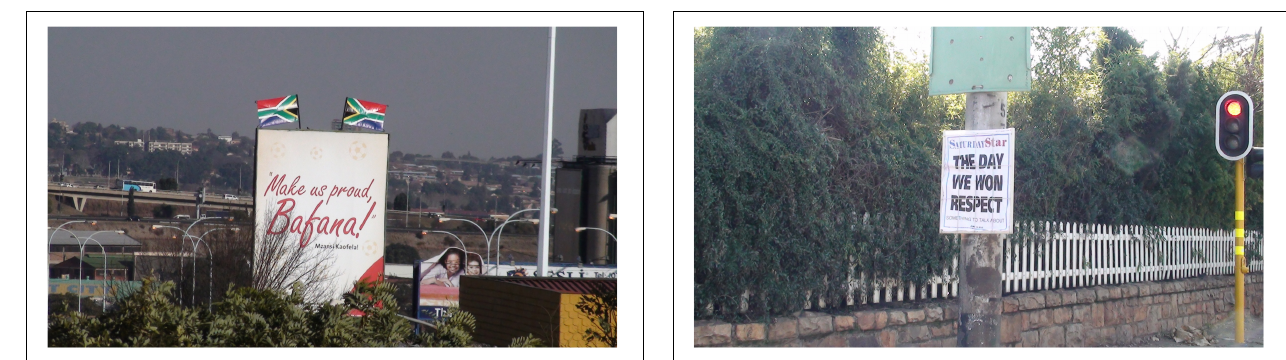
overturned in fan fest crowds along with differences between locals and foreigners: